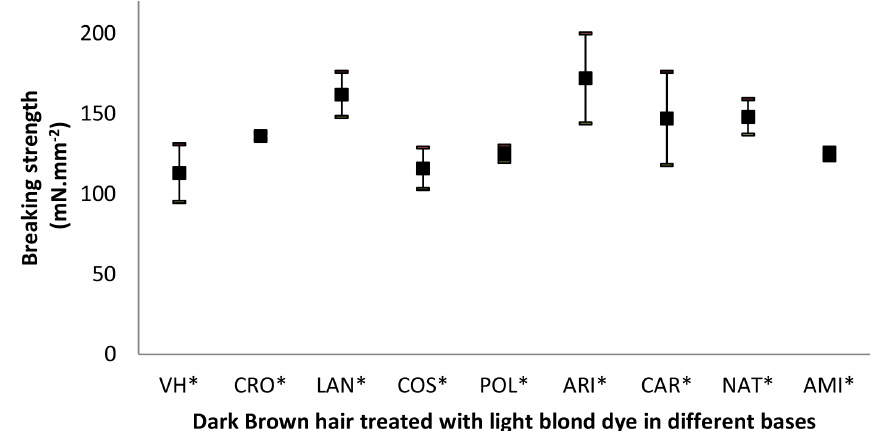
FIGURE 3 - Breaking strength for Caucasian light blond virgin hair and samples treated with light brown oxidative hair dyes. Results categorized with equal symbols (*) mean they didn’t present as statistically and significantly different, for α = 5, p < 0.05, n = 5. VH: Virgin Hair; CRO: Cetearyl Alcohol (and) Dicetyl Phosphate (and) Ceteth-10 Phosphate/ Crodafos TM CES; LAN: Cetearyl Alcohol (and) Sodium Lauryl Sulfate (and) Sodium Cetearyl Sulfate / Lanette N TM ; COS: Cetearyl Alcohol (and) Ceteareth-20/ Cosmowax J TM ; POL: Cetearyl Alcohol (and) Polysorbate 60/ Polawax NF TM ; ARI: Ammonium Acryloyldimethyltaurate (and) VP Copolymer/ Aristoflex avc TM ; CAR: Carbomer/ Carbopol TM 980 ; NAT: Hydroxyethylcellulose/ Natrosol TM HHR ; AMI: Sclerotium gum/ Amigel TM